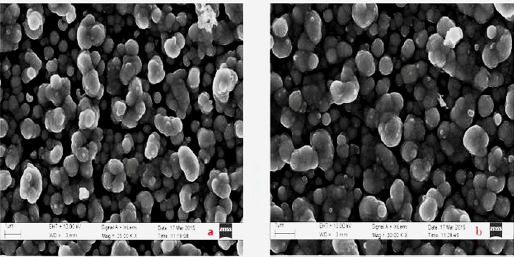
Figure 4: FESEM image of (a) ZnS and (b) 5% Sn: ZnS .